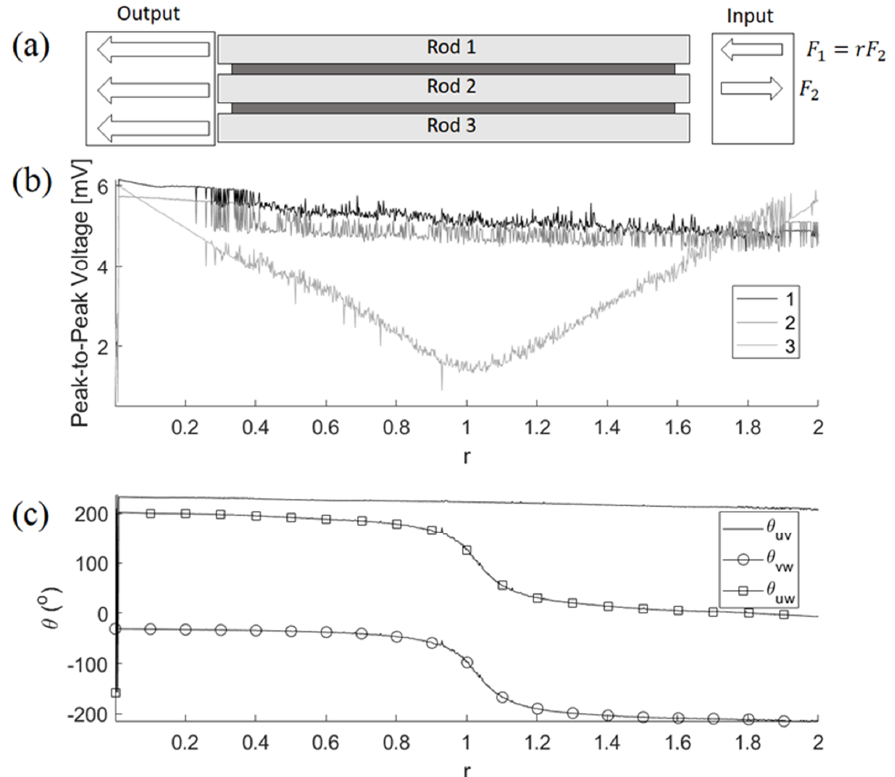
Figure 6. ( a ) Schematic of the approach used to measure the amplitude at and the phase differences between the rods when stimulated with a driving force, (cid:1832)⃗ = ((cid:1870)(cid:1832) (cid:2870) , −(cid:1832) (cid:2870) , 0) . ( b ) Magnitude of the amplitude (expressed as peak-to-peak voltage) at the detector end of each rod (labelled 1, 2, and 3) as a function of the driving parameter r . ( c ) Phase differences θ uv , θ vw and θ uw between displacement fields at the detector ends of the rods. The frequency of the drivers is 25.1 kHz.